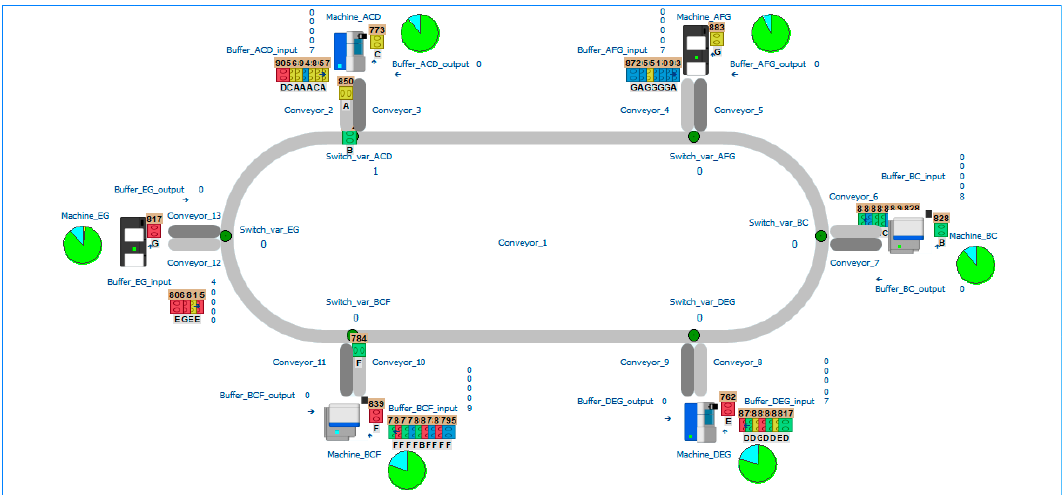
Figure 1. Simulation model of a flexible job-shop production system [46].